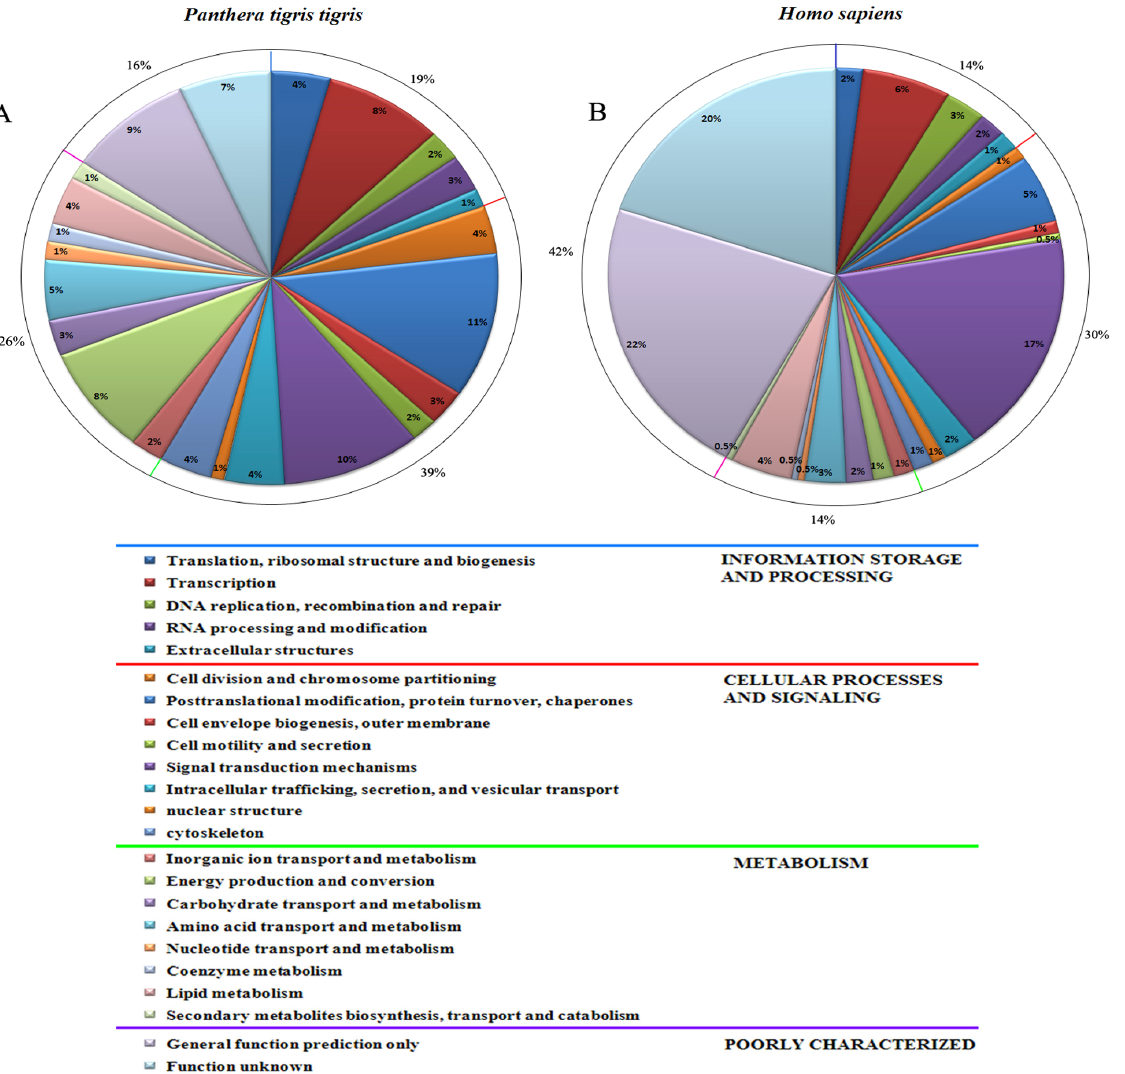
Figure 4. Comparison of classification of ESTs from P. t. tigris cDNA library based on their putative functions with those of H. sapiens. Two cDNA data sets were classified into functional groups by using the Clusters of Orthologous Group (COG)